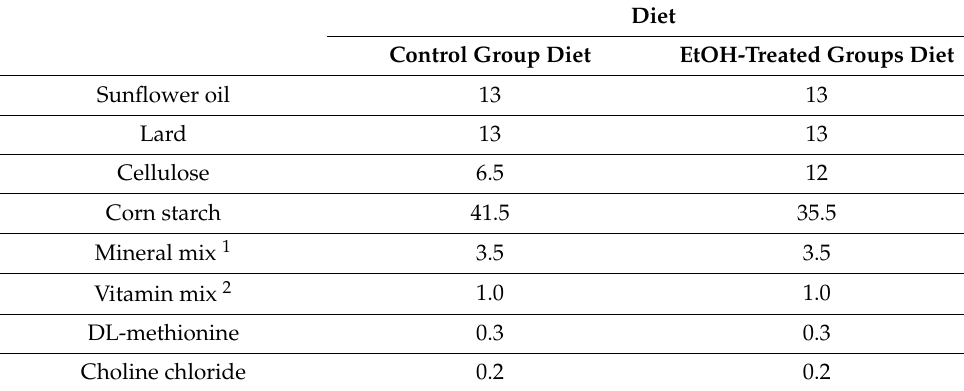
Table 1. Composition of experimental high-fat diet. Diet Control Group Diet EtOH-Treated Groups Diet Sunflower